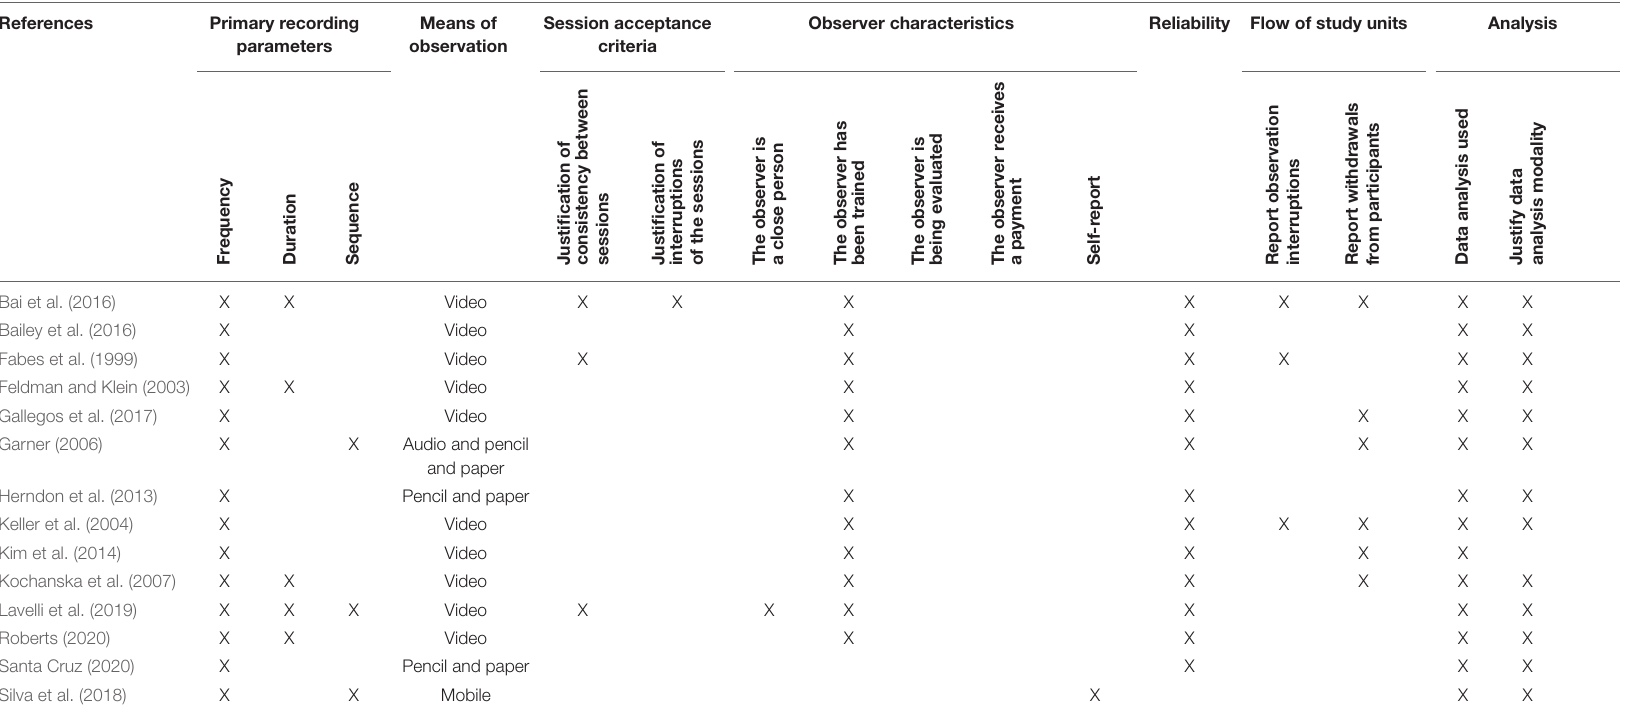
TABLE 6 | Methodological characteristics observed through Guidelines for Reporting Evaluations based on Observational Methodology -GREOM- (second